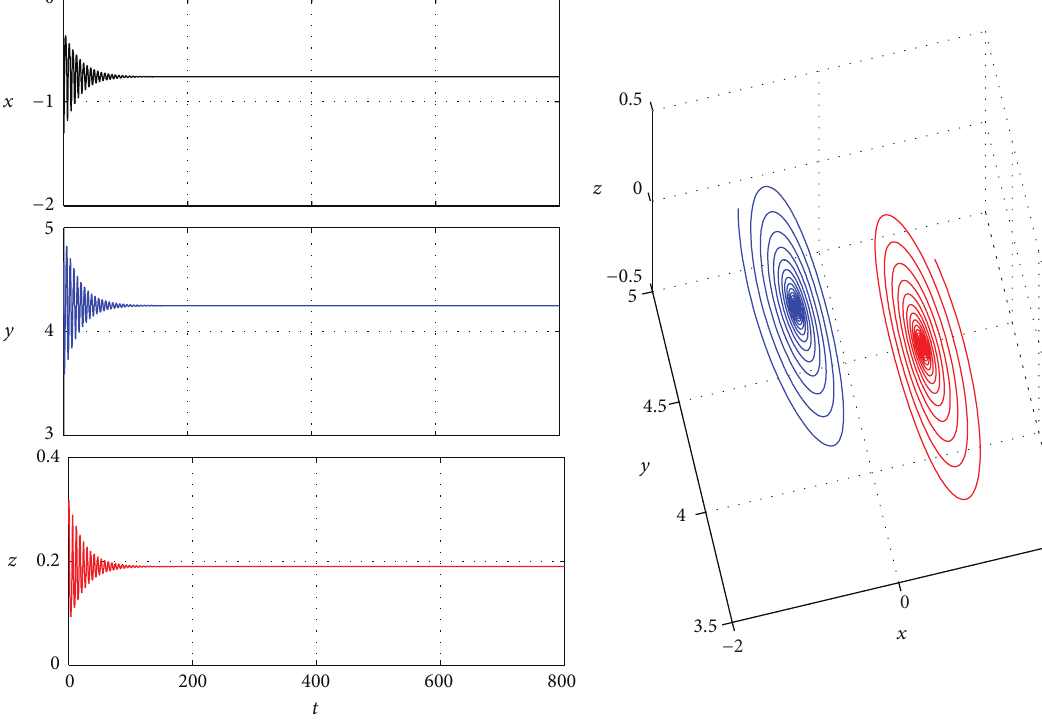
Figure 3: Trajectories 𝑥(𝑡) , 𝑦(𝑡) , and 𝑧(𝑡) and phase graphs of system (1) with 𝑎 = 4 , 𝑏 = 0.1 , and 𝑐 = 4 .